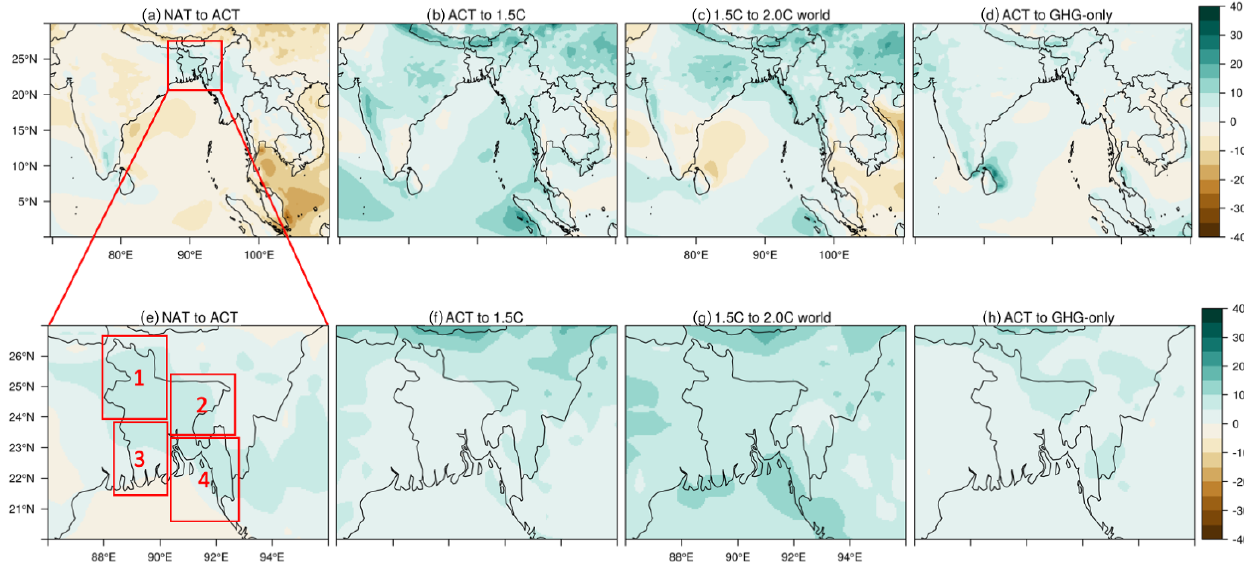
Figure 3. Same as Fig. 2, but for JJAS rainfall dPercent. The four boxes (1–4) of (e) represent the four sub-regions of Bangladesh. This figure shows that the apparently non-linear response between (a, b, c) (or e, f, g ) can be explained by the response for GHG-only (anthropogenic aerosols reduced to pre-industrial levels) in (d) (or h